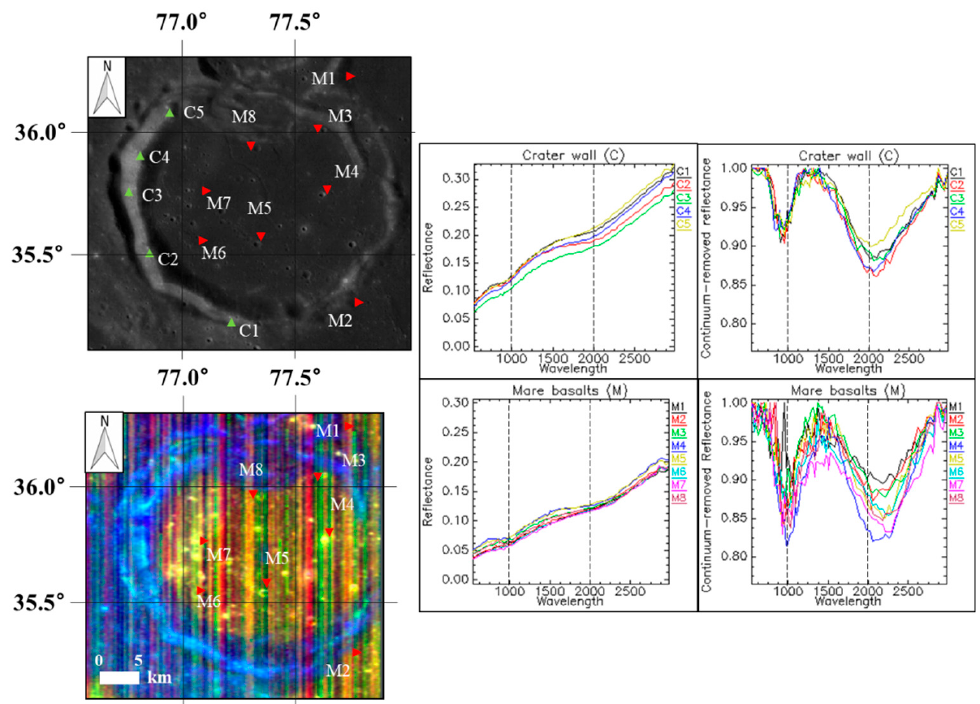
Figure 8. The WAC base map of the crater Lavoisier C (Figure 4d) shows the locations in the crater wall (C1–C5) and mare basalts (M1–M8). The WAC base map was taken from https://quickmap.lroc.asu.edu, accessed on 1 April 2022. To the right, the corresponding reflectance spectra and continuum-removed spectra are shown. The dashed lines in the spectra indicate the wavelengths of 1000 nm and 2000 nm. On the lower left, the RGB composite derived from the M 3 level 2 data is shown.